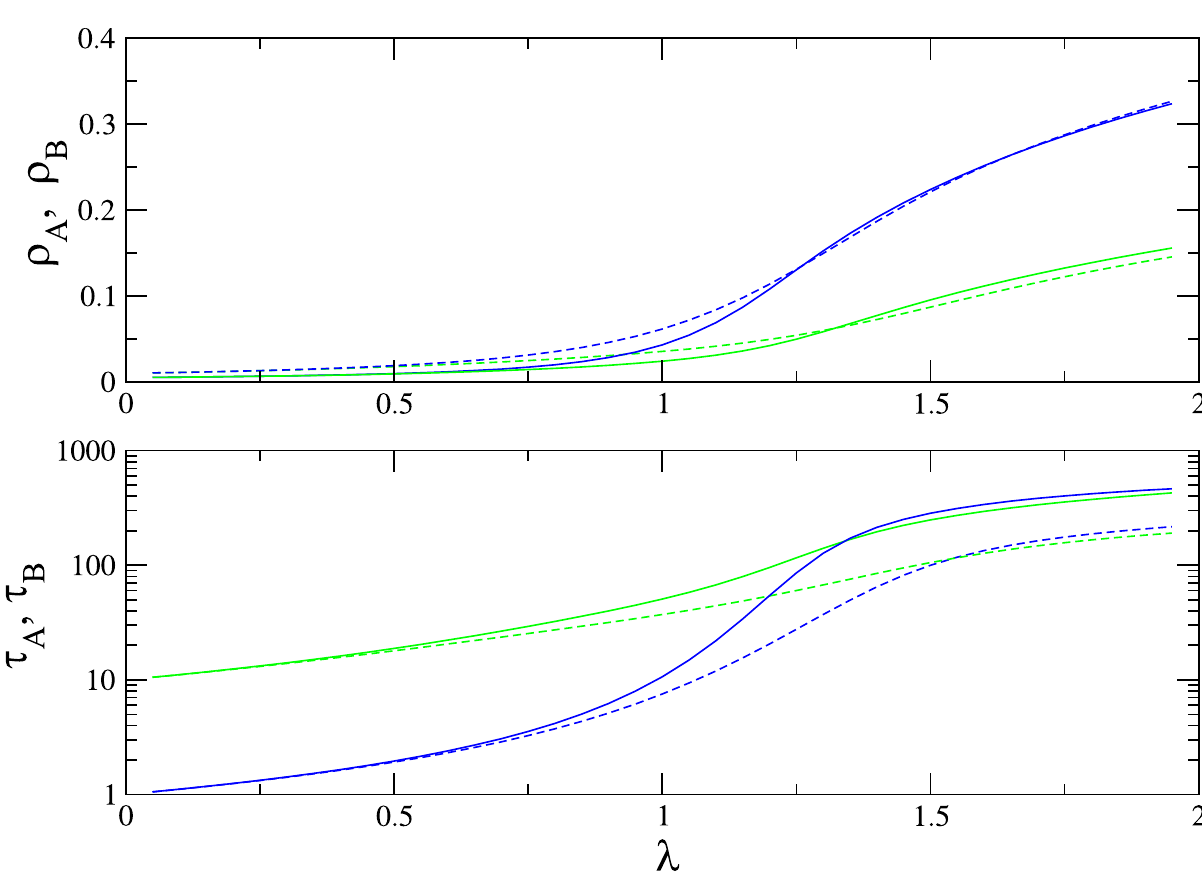
Fig 10. (Color online) Quasistationary population densities (upper panel) and lifetime of the QS state (lower panel) on a complete graph for species A (blue) and B (green) versus λ , for α = 0.1. Graph sizes: N = 100 (dashed)and N = 200.